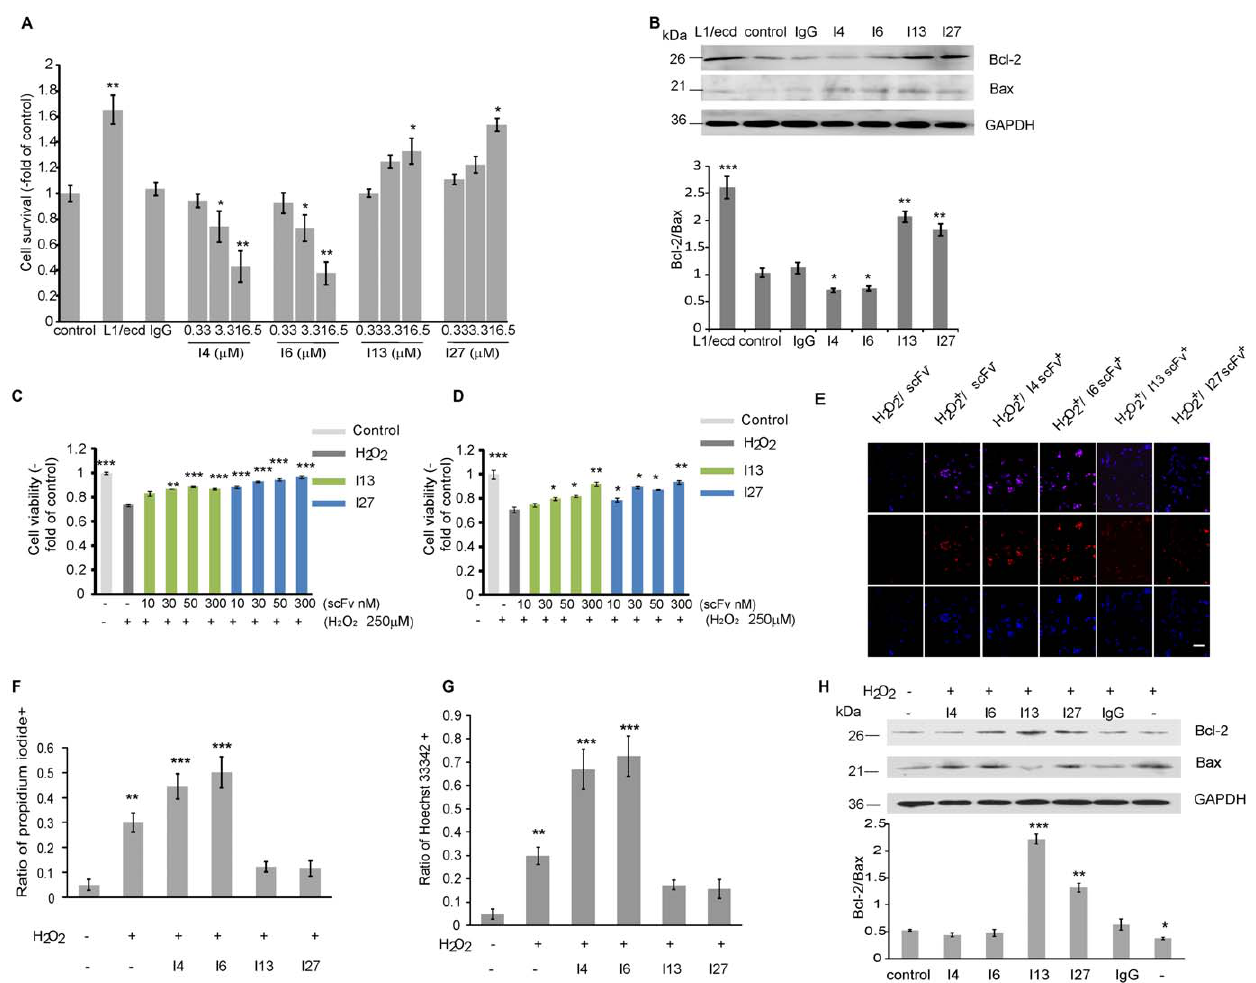
Figure 7. ScFvs against Fn1–3 protect cells from H 2 O 2 –induced death and increase the ratio of Bcl-2/Bax. SK-N-SH cells were seeded into poly-D-lysine (PDL)-pretreated culture plates coated with L1/ecd (as positive control), non-immune human IgG (as negative control), and scFvs I4, I6, I13, or I27 and maintained for 5 days in serum-free medium. In addition, SK-N-SH cells grown for 12 hours were pre-incubated with 250 m M H 2 O 2 for 2 hours in serum-free medium. After removal of H 2 O 2 , scFvs I13 and I27 were added at the indicated concentrations and cells were cultured for additional 24 hours. ( A ) ScFvs treatment for 5 days. Cell survival was measured by the MST-8 assay. ( B ) L1/ecd, non-immune human IgG, scFvs I4, I6, I13 or I27 (all at 16.5 m M) treatment for 24 hours for Western blot assay of Bcl-2 and Bax protein expression. ( C ) ScFv treatment for 12 hours. ( D ) ScFv treatment for 24 hours. ( C, D ) Cell viability was measured by the MST-8 assay. Data represent mean values 6 SEM from four independent experiments. Asterisks denote significant differences from control. *** p , 0.001, ** p , 0.01, * p , 0.05 versus H 2 O 2 treatment alone, one-way ANOVA, Dunnet’s post-hoc test. ( E ) ScFvs I4, I6, I13 and I27 (all at 16.5 m M), were added after removal of H 2 O 2 for 24 hours. Cells were stained by Hoechst 33342 (blue) and propidium iodide (PI, red), merge (pink). Bar indicates 40 m m for all panels. ( F , G ) Quantification of PI and Hoechst positive cells, and calculation of the number of PI and Hoechst positive cells among the total cell number. ( B , H ) Analysis of protein levels of Bcl-2/Bax after treatment of cells with scFvs. GAPDH was used as loading control. ( B , E , F , H ) Data represent mean values 6 SEM from three independent experiments. *** p , 0.001, ** p , 0.01, * p , 0.05, Student’s t-test.